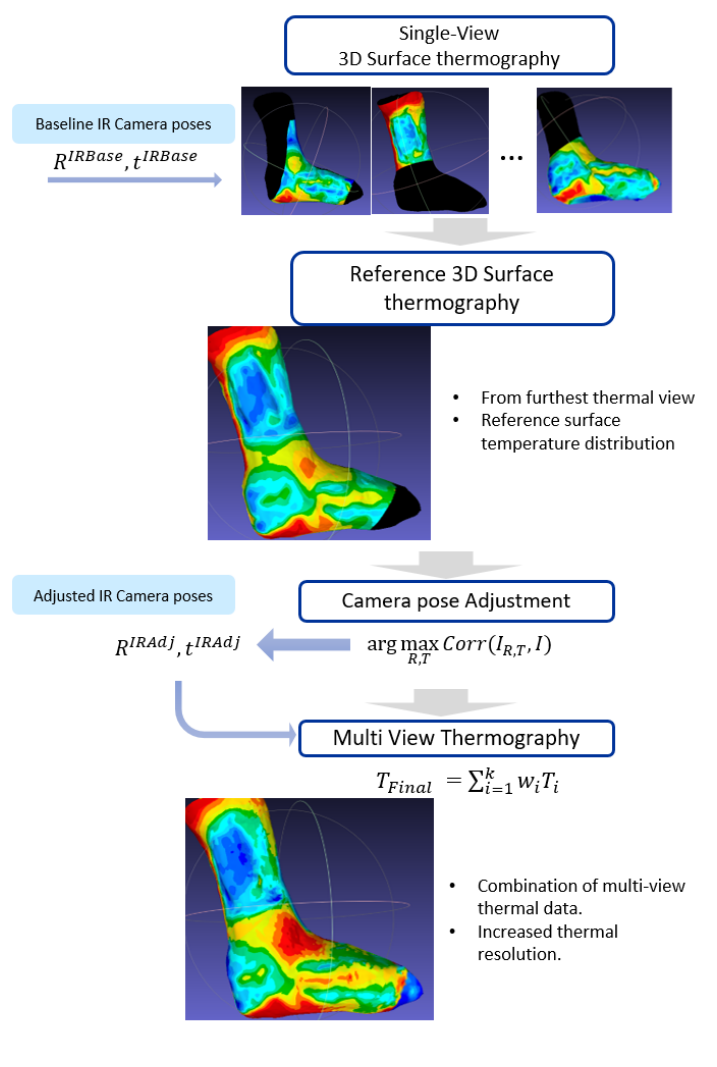
Figure 2. The proposed pipeline for creating a multi-view 3D surface thermography starting from single-view 3D surface